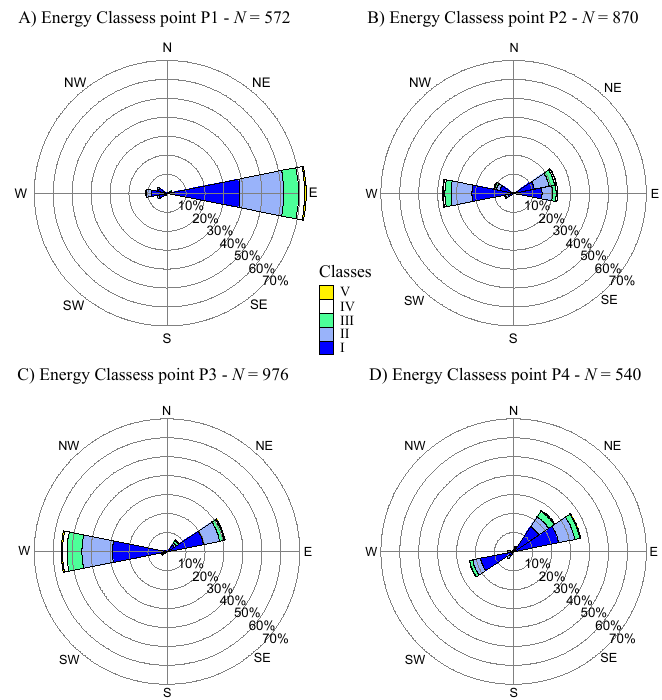
Figure 7. Energy flux roses at all prediction points. ( A ) Point P1, ( B ) Point P2, ( C ) Point P3, ( D ) Point P4. N is the total number of storm